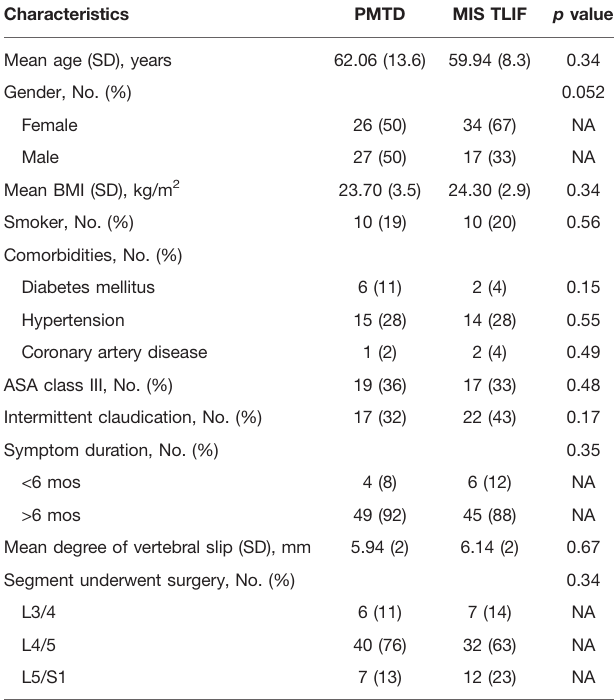
TABLE 2 | Baseline characteristics of the patients.